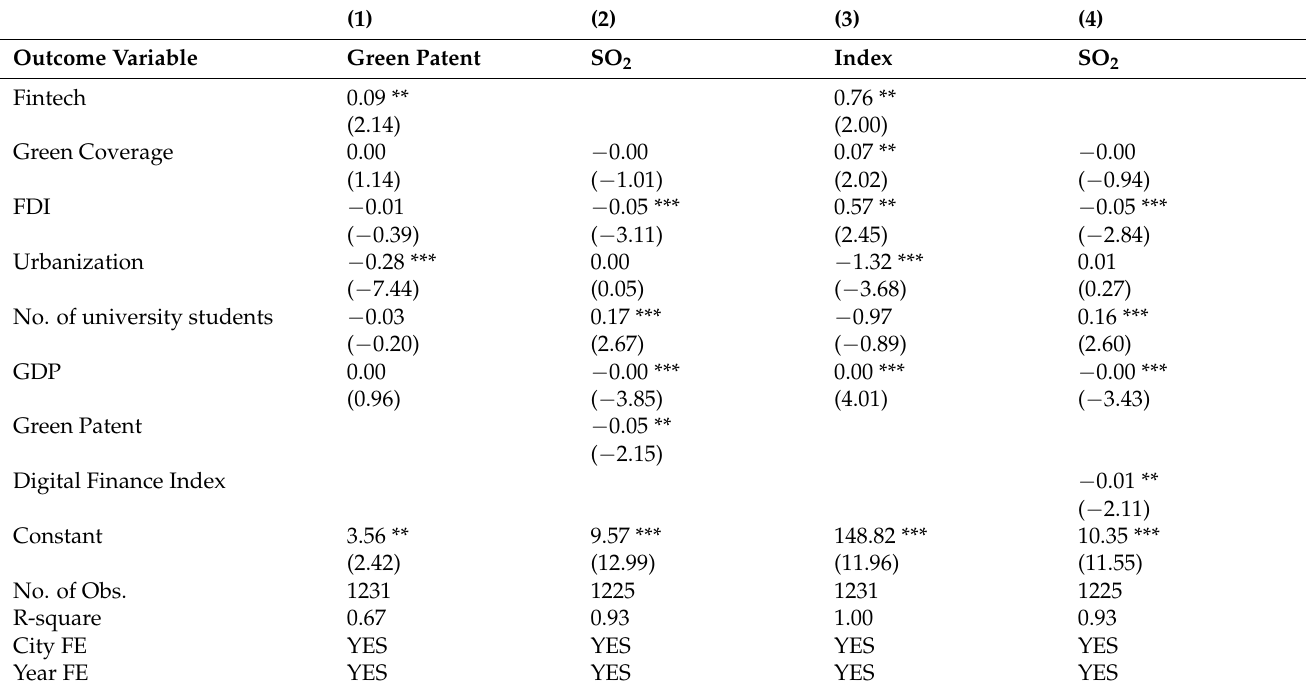
Table 5. Channel effect